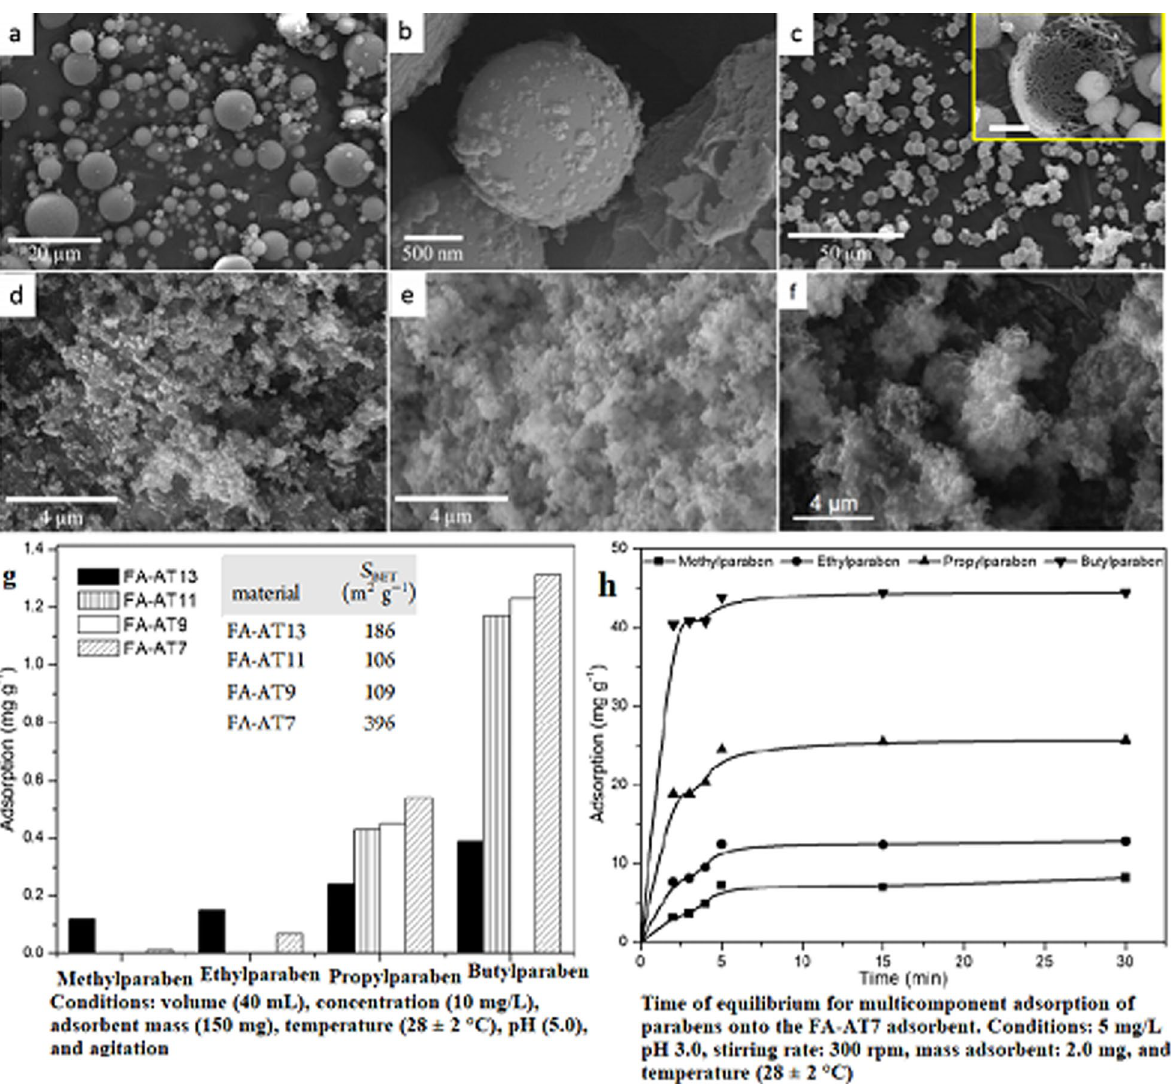
Fig. 22 Effect of acid treatment on the morphology of coal fly ash derived silica: a , b FA, c FA-AT13, d FA-AT11, e FA-AT9, and f FA-AT7, g Effect of modification on paraben adsorption, h Adsorption of Paraben onto FA-AT7 (Olivera et al.